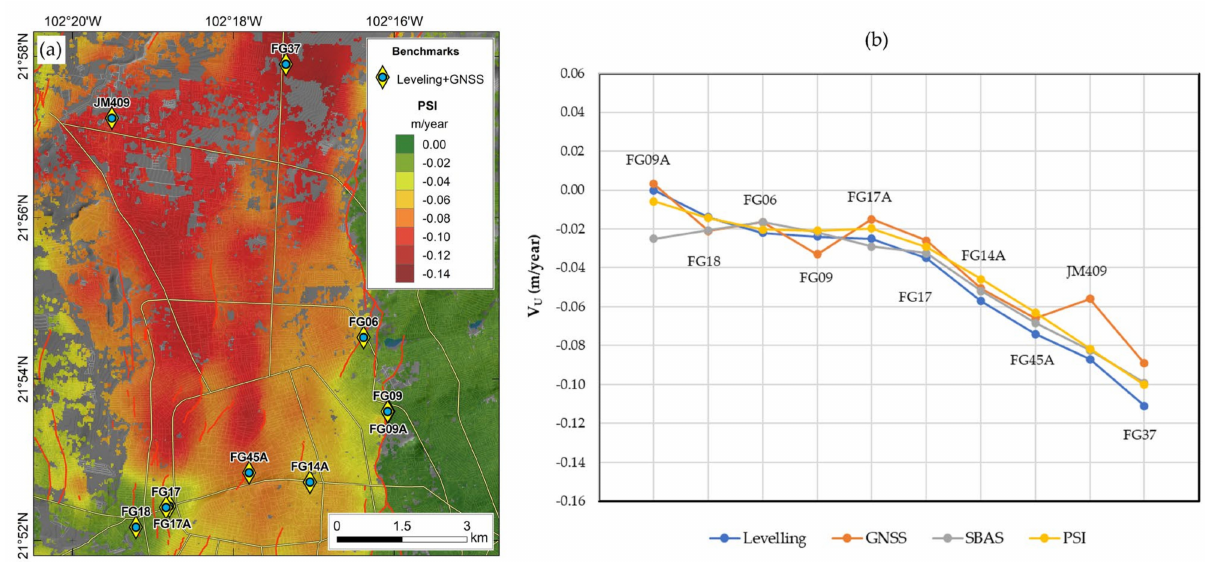
Figure 12. Displacement velocity along the vertical V U direction estimated at 10 benchmarks that were surveyed using both GNSS and geodetic leveling: ( a ) location map onto PSI-derived V U and ( b ) comparison plot. The benchmarks are sorted in ( b ) according to their V U estimated via